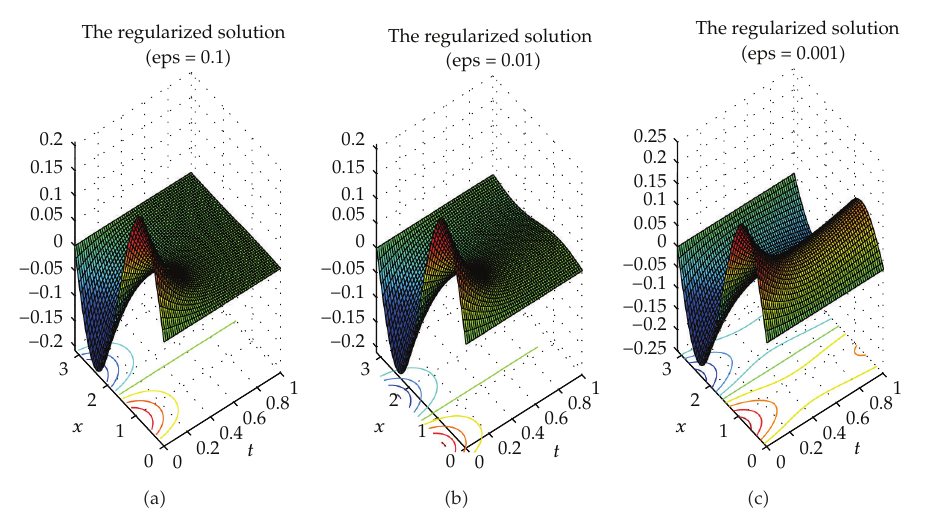
Figure 1: The regularized solutions corresponding to δ i , i (cid:5) 1 , 2 , 3.